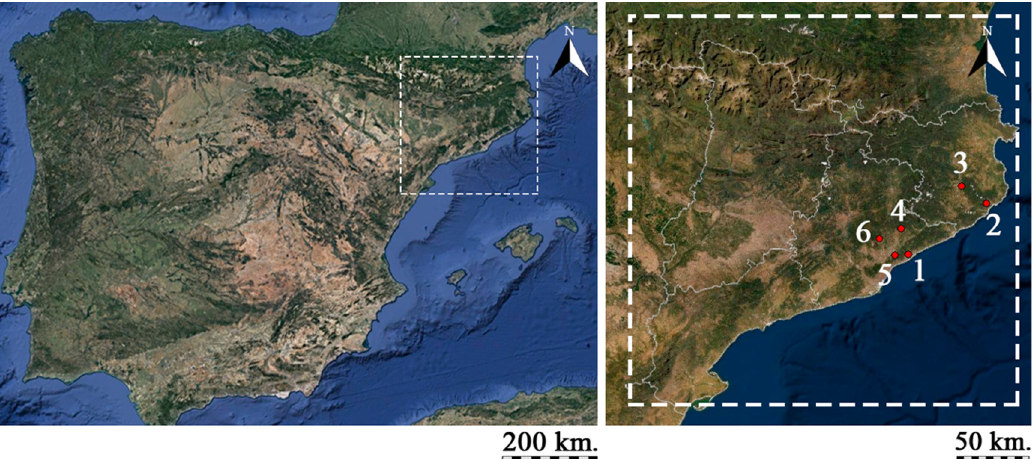
Figure 1. The location of Burriac (1), Castell Barri (2), Puig d’en Rovira (3), Puig Castell (4), Sant Miquel (5), and Torre Roja (6), the settlements under study, in the NE of the Iberian Peninsula (within the white line